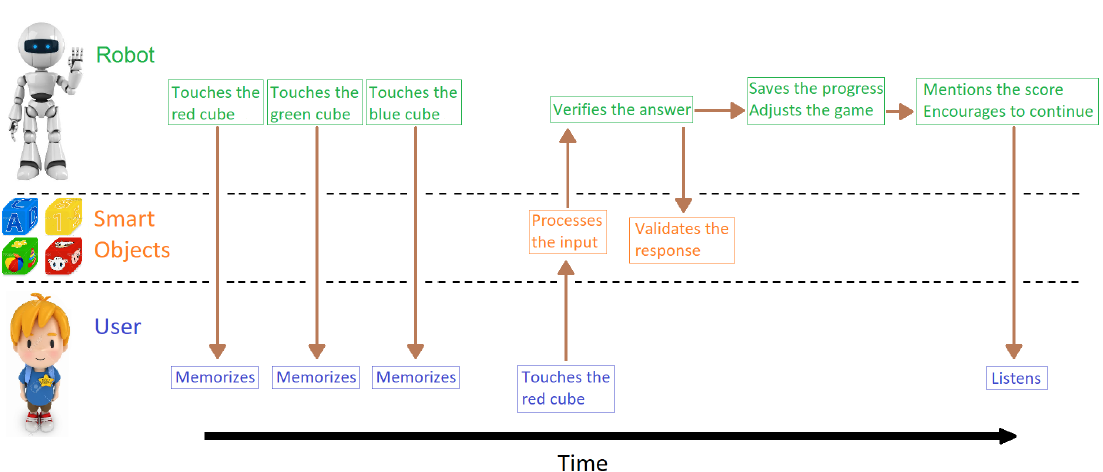
Figure 1. Graphical representation of the interaction among the user, the robot and the smart objects. As an example, the first iteration of the two-back case is